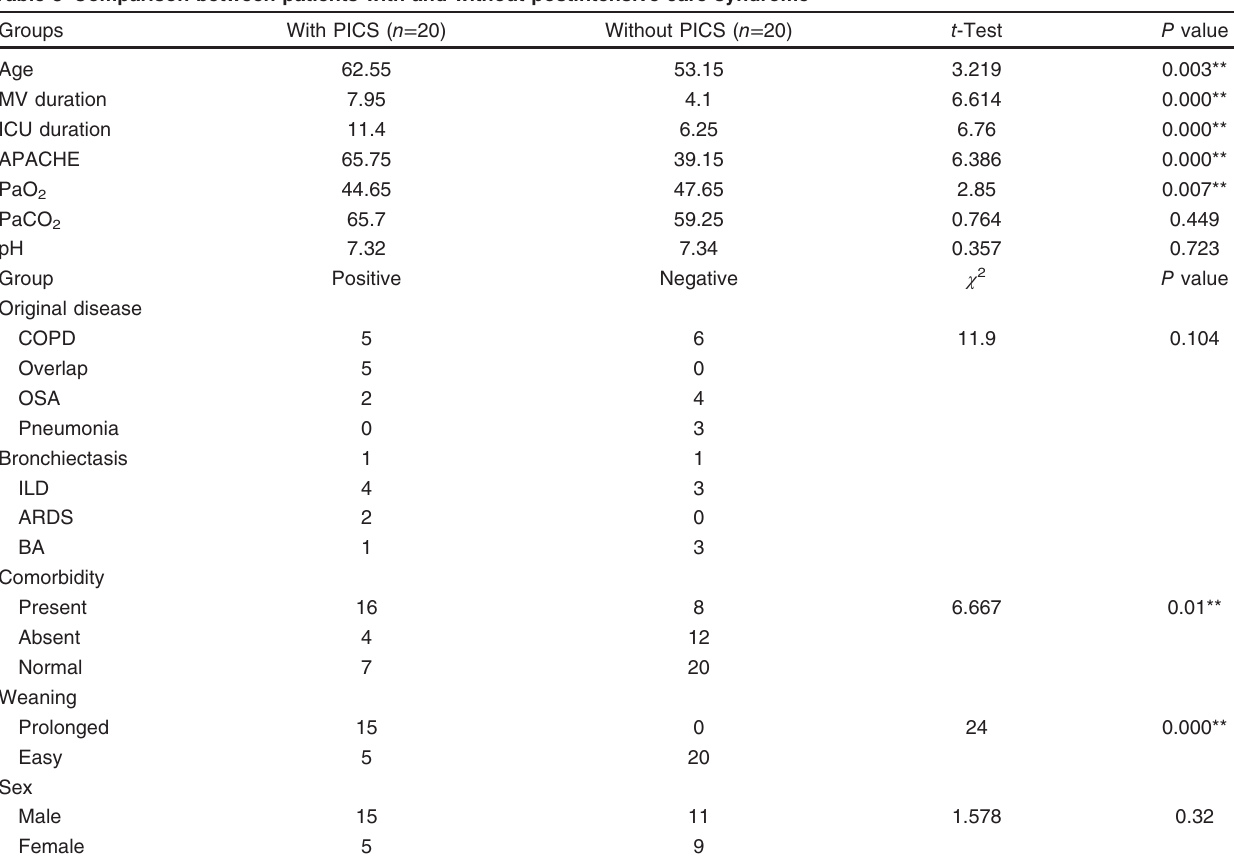
ARDS, adult respiratory distress syndrome; APACHE, acute physiology and chronic health evaluation; BA, bronchial asthma; COPD, chronic obstructive airway disease; ILD, interstitial lung disease; MV, mechanical ventilation; OSA, obstructive sleep apnea; PICS, postintensive care syndrome. *Significant. **Highly significant.